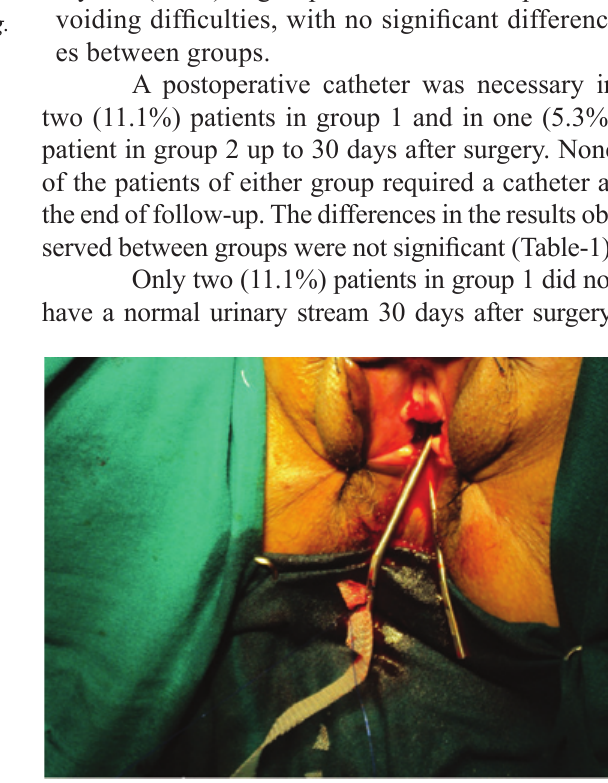
Figure 4 – Passage of hand-made polypropylene